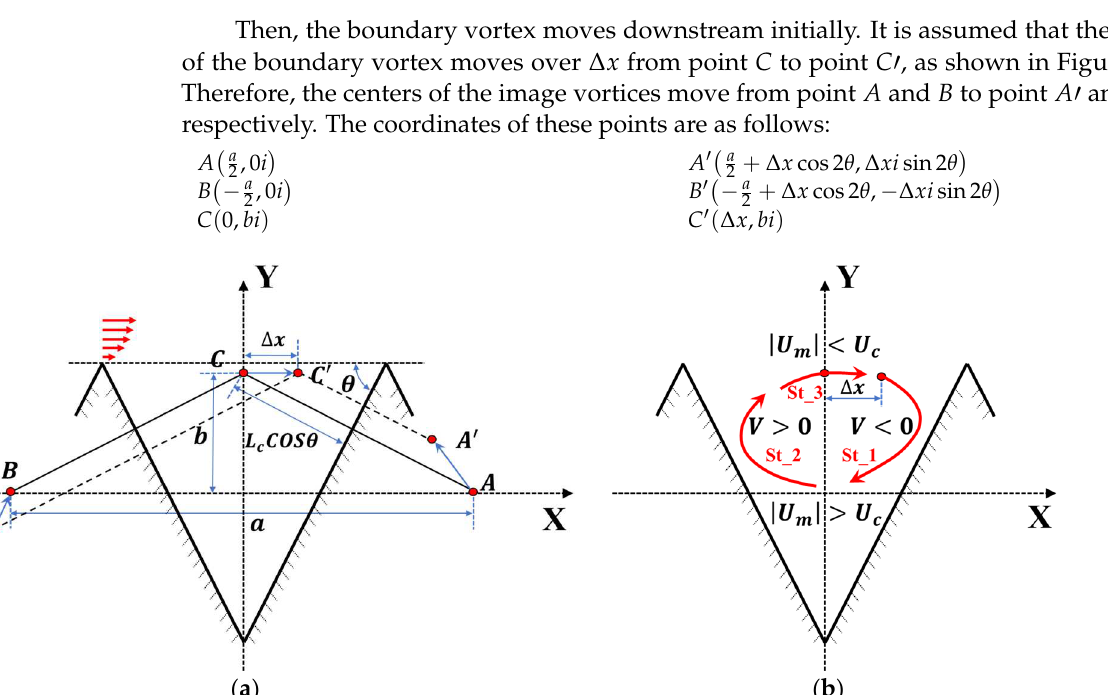
Figure 10. Kinematic analyses of boundary vortices when AR < 2.15. ( a ) Coordinates of boundary vortex and image vortices; ( b ) moving path of boundary vortex.